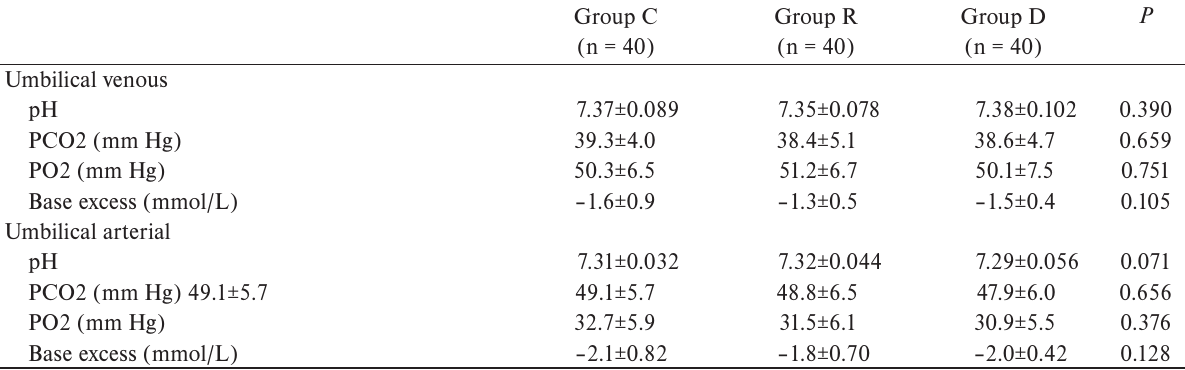
Table 3. Umbilical blood gases values.